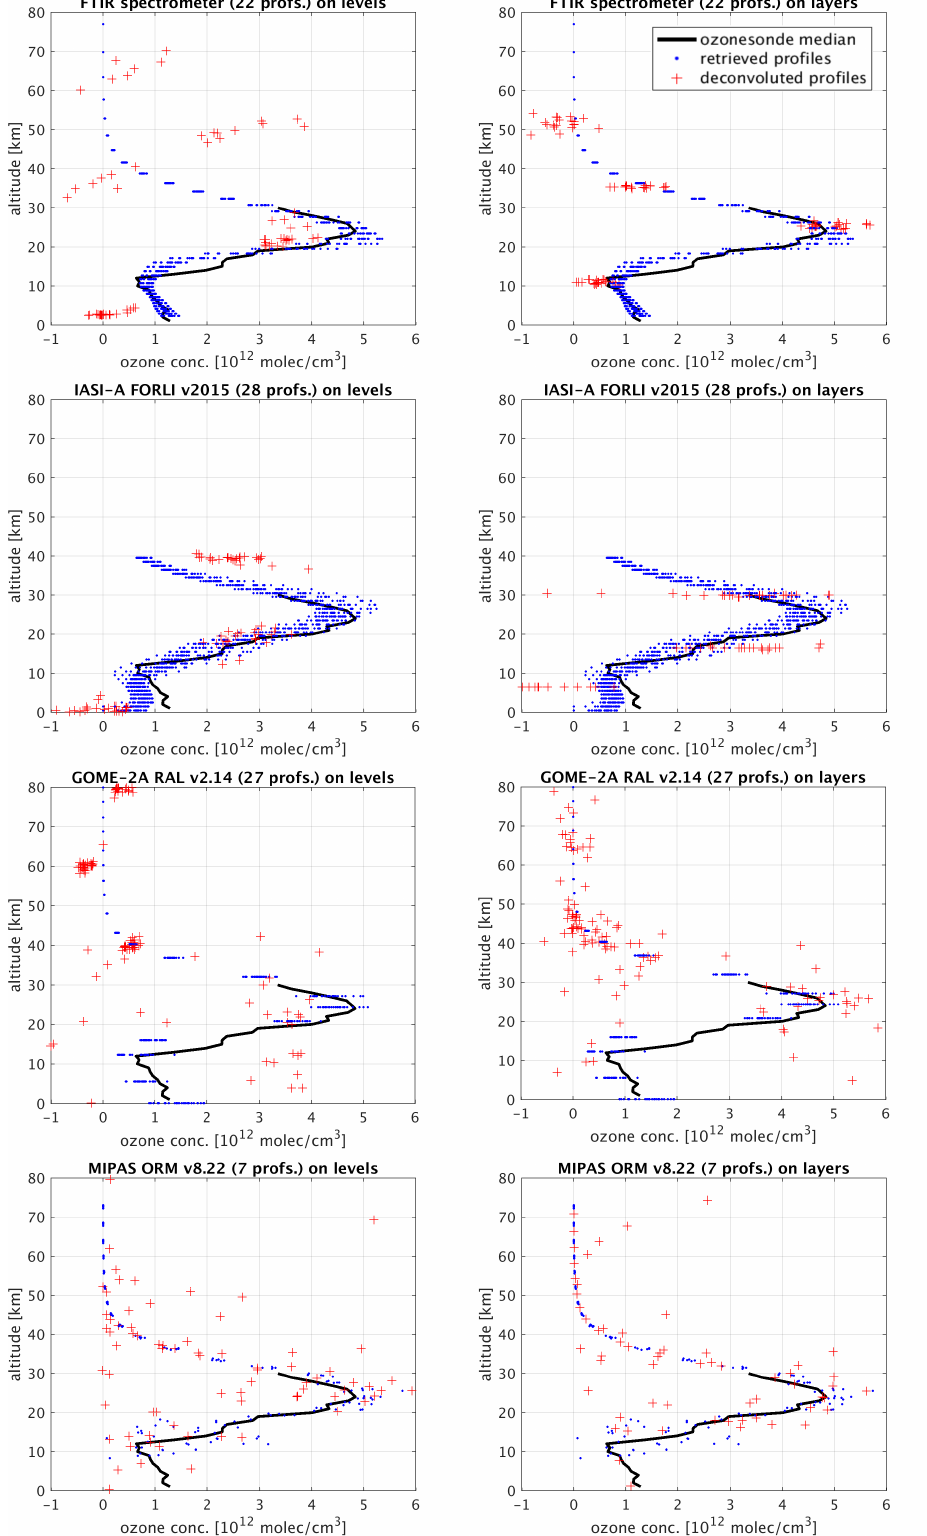
Figure 2. Ozone profile retrievals (blue dots) and deconvoluted ozone profiles (red crosses) from the NDACC FTIR, IASI-A, GOME-2A, and MIPAS instruments (top to bottom) for April 2012 at Izaña (see coincidence criteria in Table 2). Deconvolutions are performed for d − levels ( left ) or layers ( right ). Black lines show the median of the ozone profiles measured by ozonesonde at Izaña (4 launches in April